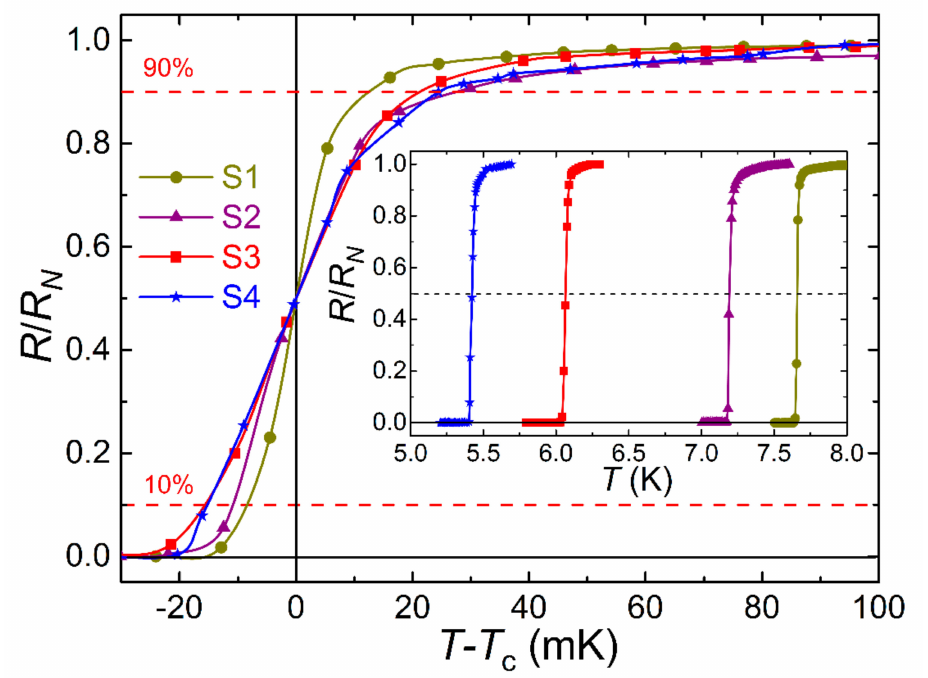
Figure 5. Resistive superconducting transitions of the single VN film (S1), the bilayer Structures S2 and S3, and the pseudo-spin-valve Structure S4, at zero magnetic field. Lines connecting symbols are drawn using a modified Bezier algorithm. Measurements with the sensing currents of 20 and 100 µ A did not reveal any difference in the width and shape of the